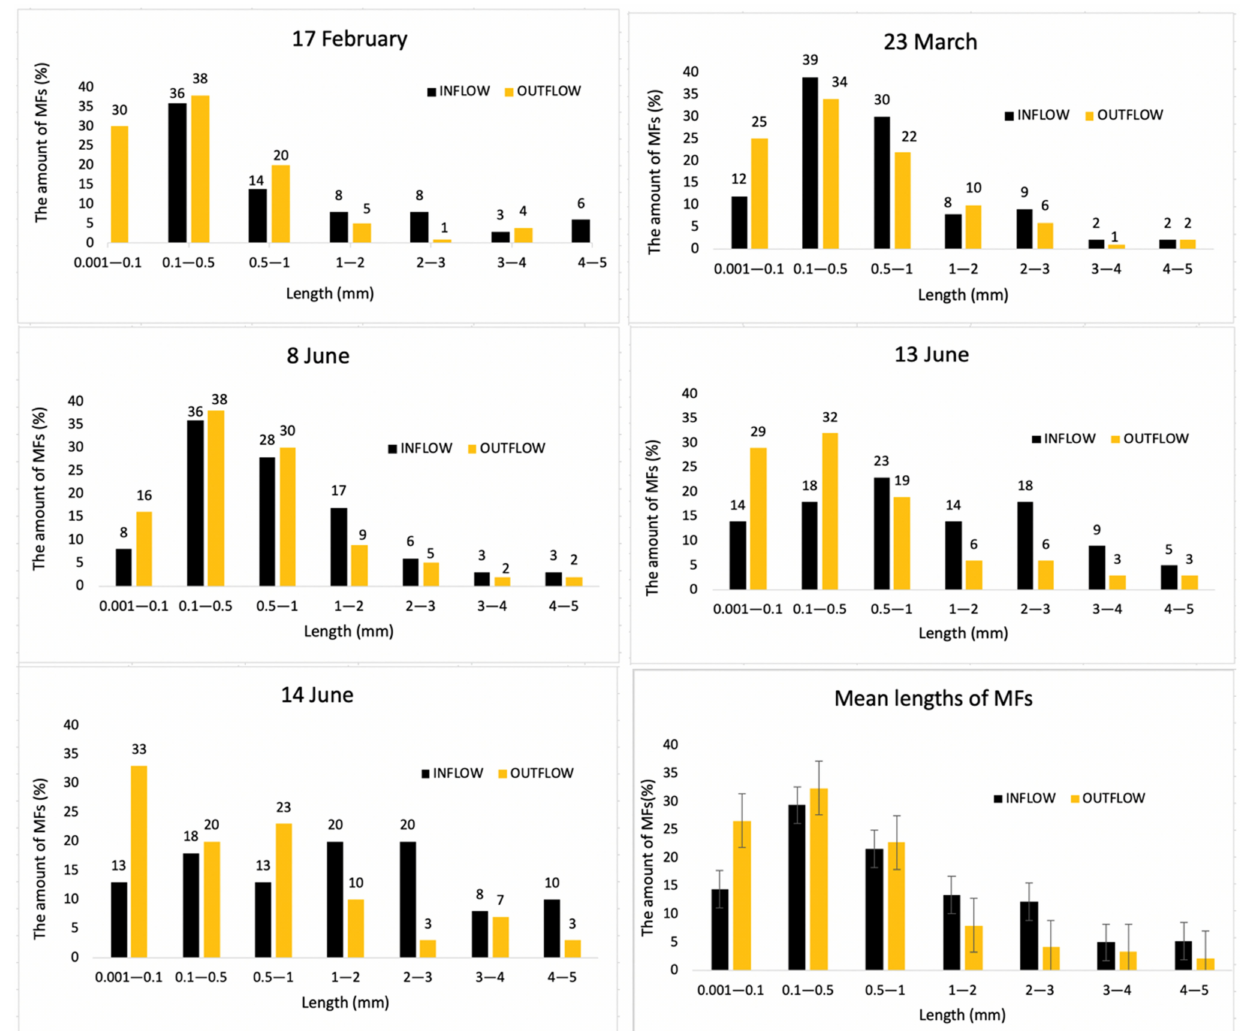
Figure 3. Distribution of MFs’ lengths in the inflow and outflow